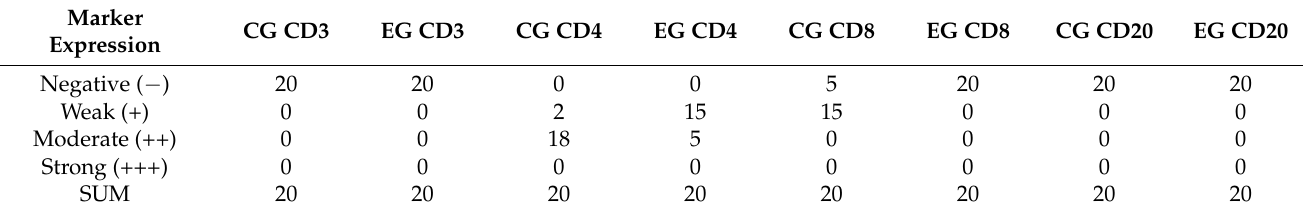
Table 4. CD3, CD4, CD8, and CD20 antigen expression intensity in the chorionic villi